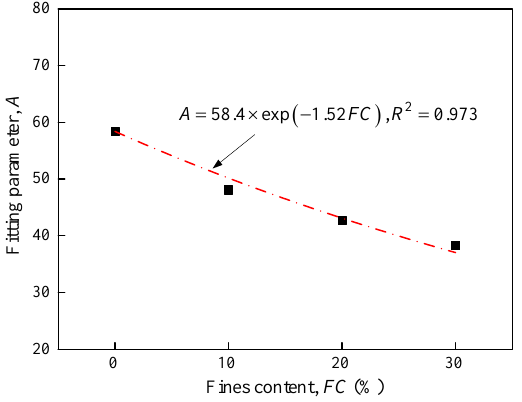
Figure 7. The relationship between A of the Hardin model and FC for Nantong marine silty sand.